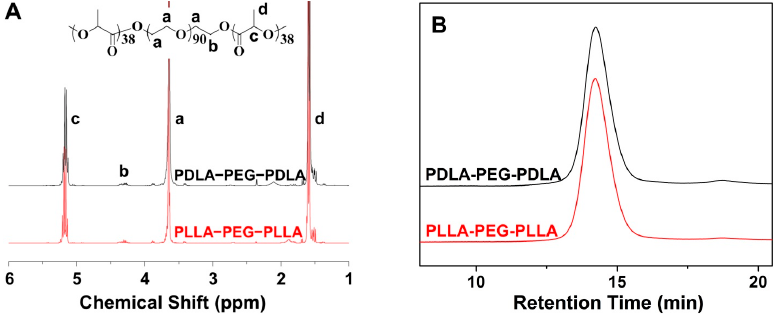
Table 1. Characterization of PLA–PEG–PLA copolymers. Figure 1. 1 H NMR spectra (in CDCl 3 ) ( A ) and GPC chromatograms ( B ) of PDLA–PEG–PDLA and